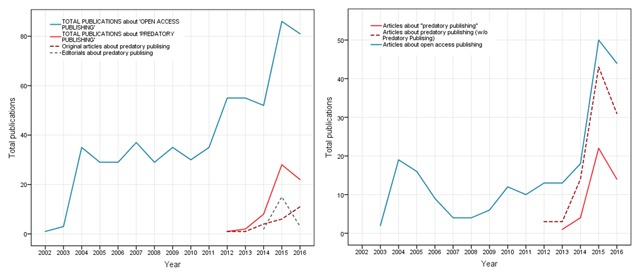
Scopus (Left) and PubMed (right) trend reports of number of articles about Predatory Publishing (PP, red) and Open Access (OA, blue) by year. Correlations between PP-OA trends were high (Scopus r = 0.72 PubMed r = 0.87). By t-tests, differences in Scopus were in the limit (p = 0.05) and in PubMed were non-significant (p > 0.05). In Scopus, the growing trend predominantly relies on original articles (dotted red line).